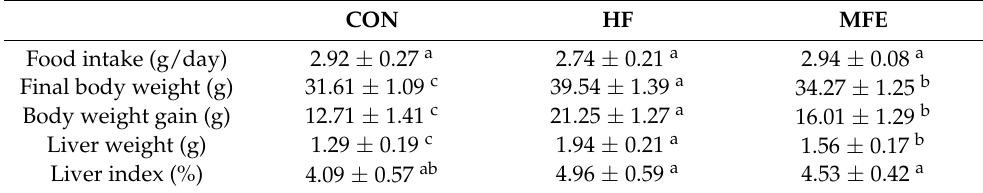
Table 2. The effect of MFE on food intake and body and liver weight in high-fat-diet mice.